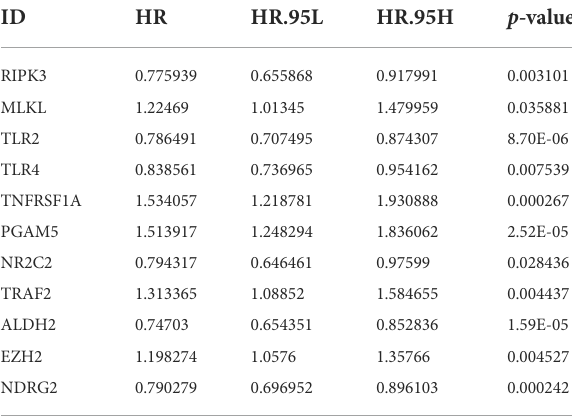
TABLE 1 Univariate Cox analysis of prognostic